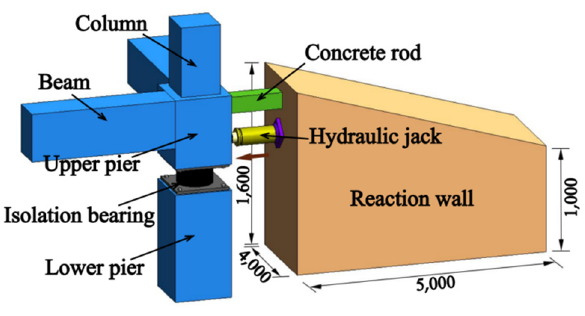
Figure 12. Schematic diagram of a test loading and unloading device (unit: mm).